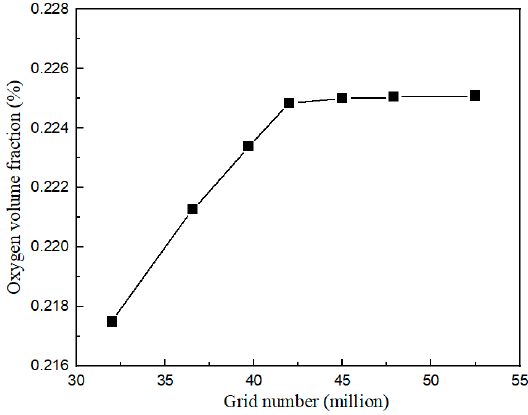
Figure 3. Verification results of grid independence.